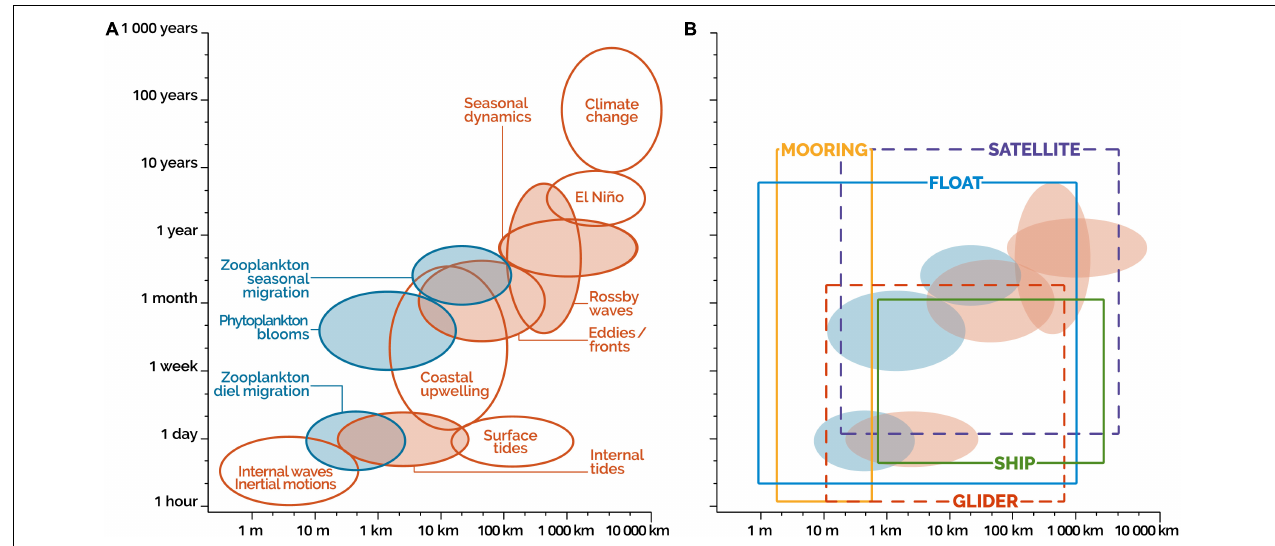
FIGURE 1 | Semiquantitative representation of spatial (geographical, horizontal) and temporal scales of important marine physical dynamic (red ellipses) and ecosystem (blue ellipses) processes (modified from Chai et al., 2020, Figure 2). (A) Filled ellipses: processes of significance to BCPs. (B) BCP-relevant processes from panel (A) (ellipses) and spatio-temporal ranges of five observation platforms (rectangles): satellites, ships, floats, gliders, and moorings. The geographical ranges of fleets of mobile platforms and mooring networks will be wider than those of individual mobile platforms and moorings illustrated in panel (B) .